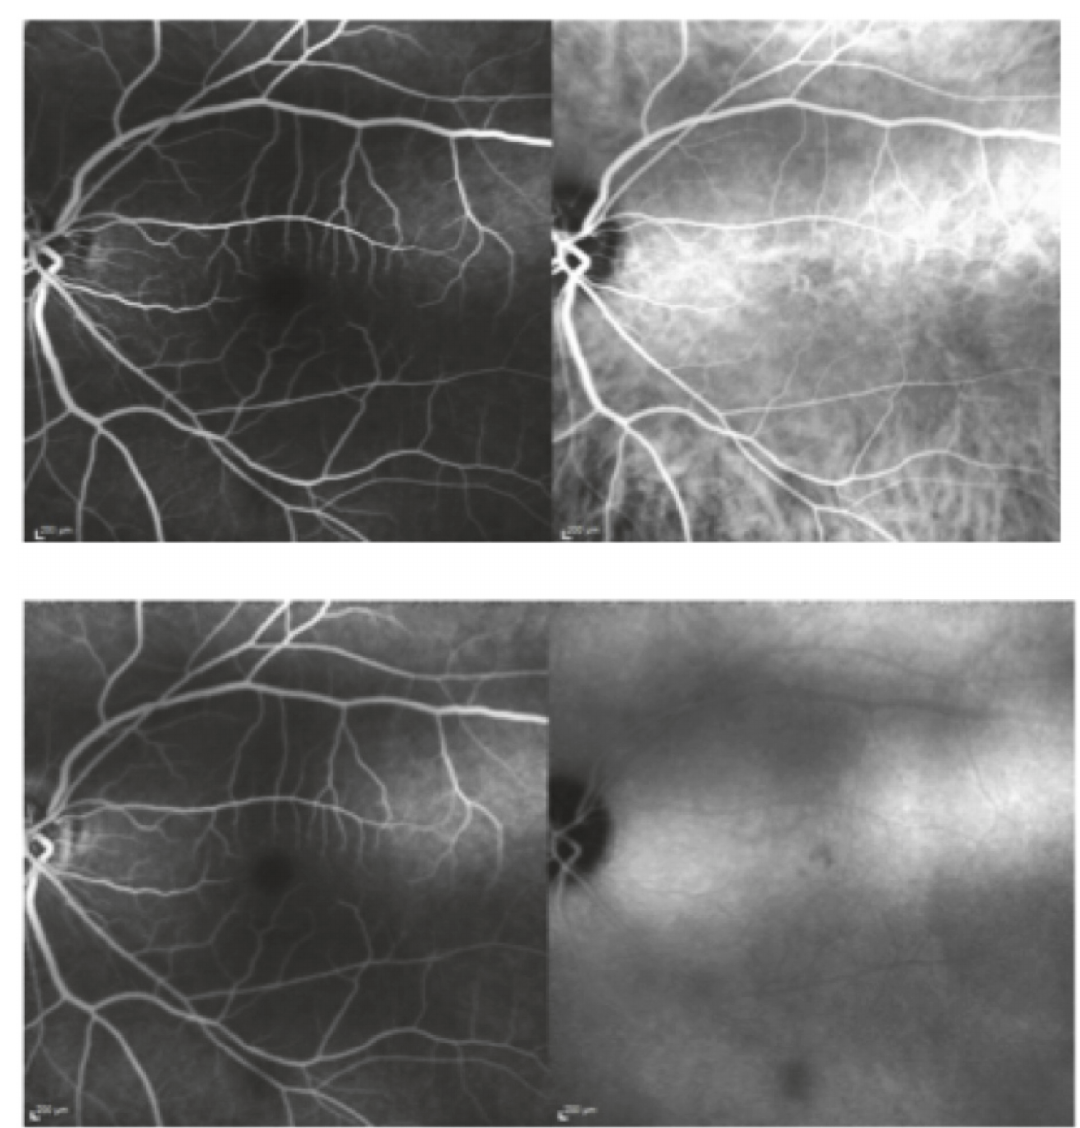
Figure 6: On the left early and late fluorescein (FA), and on the right early and late indocyanine green (IA) angiography. Late IA reveals a hypofluorescent area temporal to the